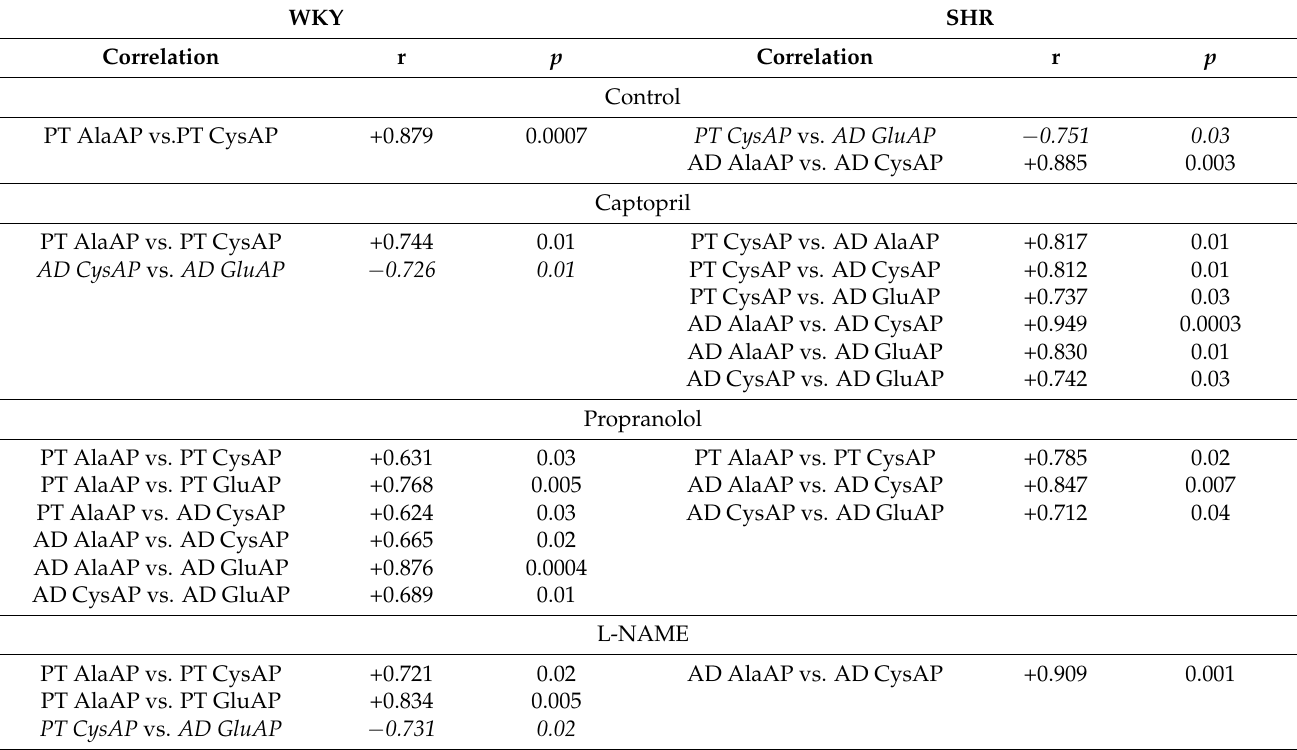
Table 1. Positive or negative significant correlations between the aminopeptidase activities analyzed in the pituitary and adrenal glands of each group of treatments in WKY and